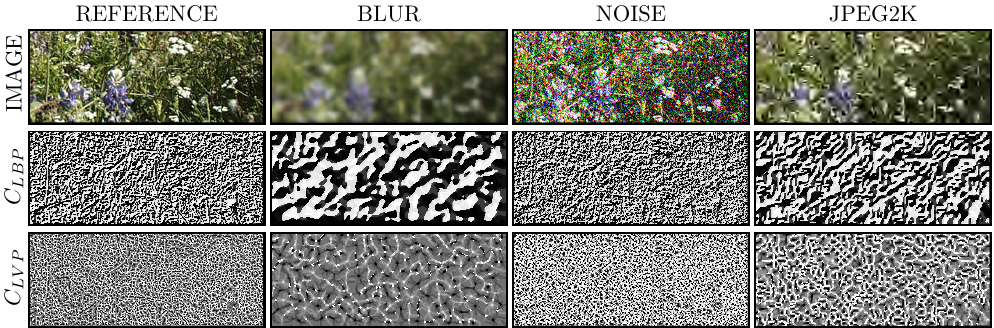
Figure 19. Reference image, its impaired versions, and their respective LBP and LVP maps ( C LBP and C LVP